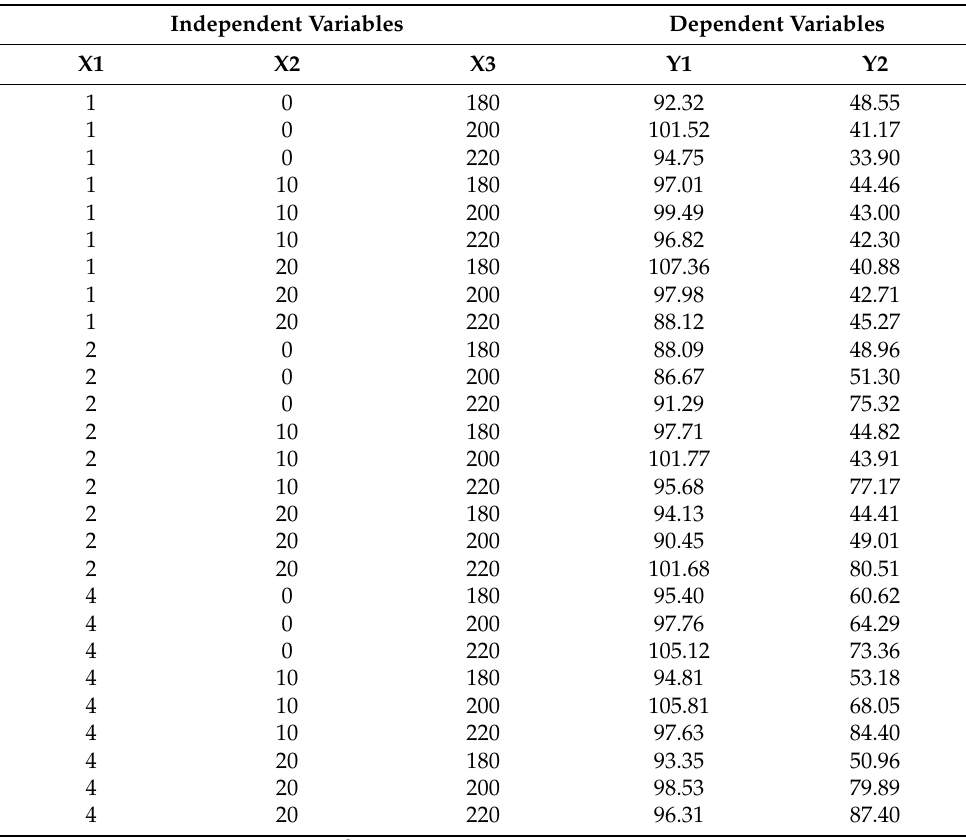
Table 2. Preformulation experimental design of hot-melt extruded